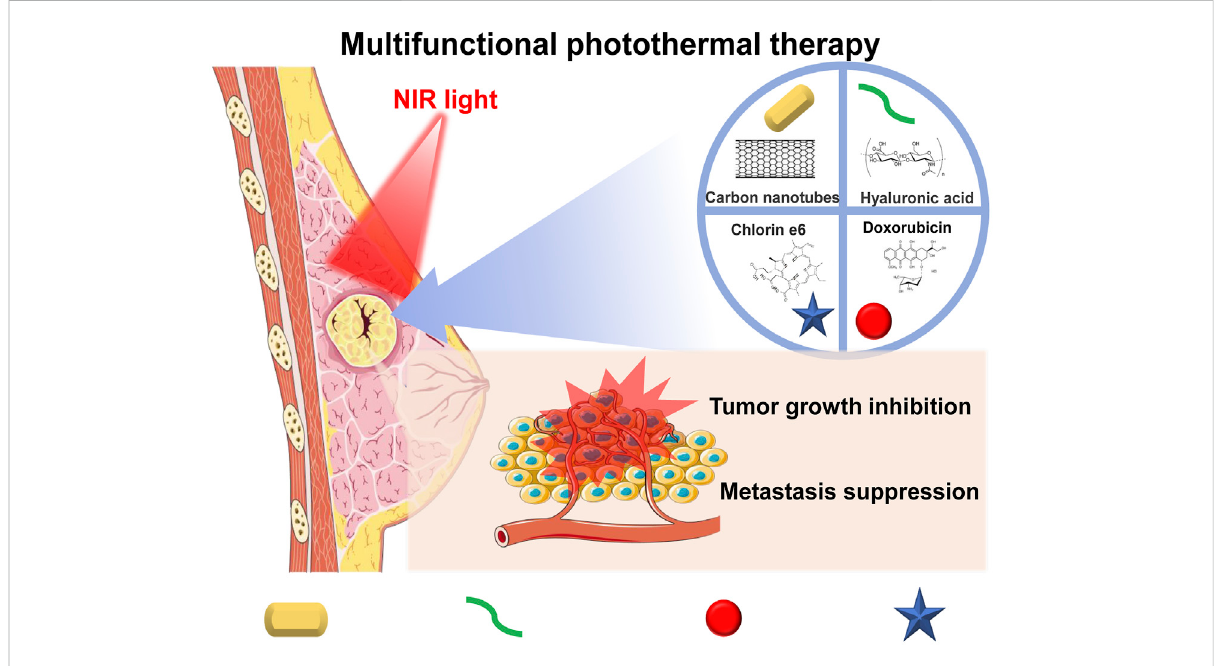
FIGURE 1 Photothermal therapy combined with chemotherapy or/and photodynamic therapy to achieve a synergistic therapeutic effect to inhibit breast cancer primary tumor and